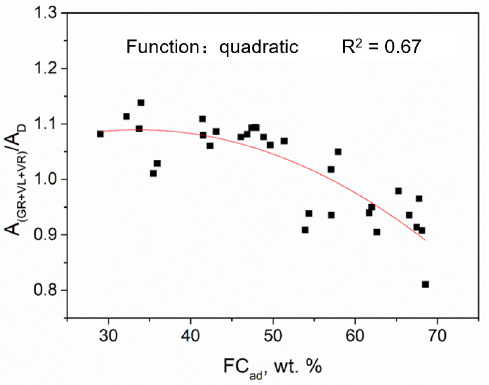
Figure 8. The correlation between FC ad in parent coal and A (GR+VL+VR) /A D of its pyrolytic char.